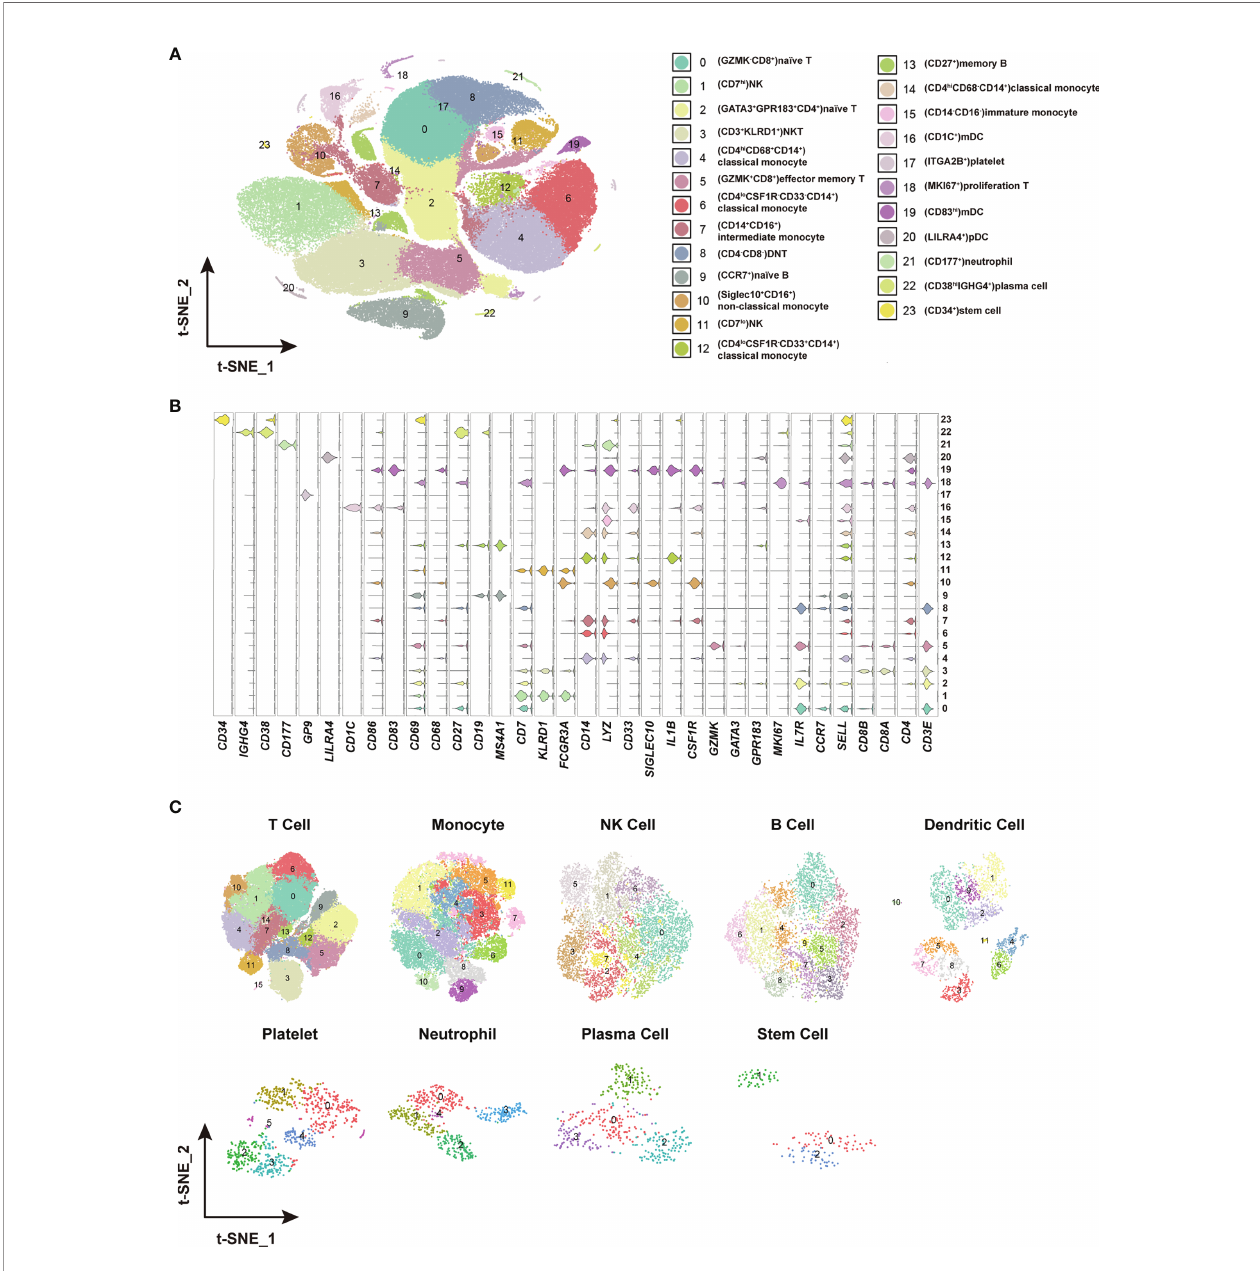
FIGURE 2 | Identi fi cation of distinct cell clusters and sub-clusters in the PBMCs. (A) The t-SNE plot showing 24 cell clusters with separate color labels and marked by signature gene. (B) The violin plots showing the expression pattern of the selected cell markers in each of the 24 clusters. The marker gene expression level was calculated via LogNormalize method of the “ NormalizeData ” function of the Seurat software. (C) The t-SNE plots showing the sub-clusters of T cells, monocytes, NK cells, B cells dendritic cells, platelets, neutrophils, plasma cells and stem